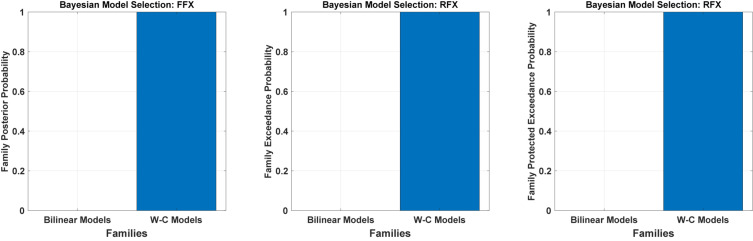
Results of Bayesian model comparisons for all possible models in the Family-level with standard bilinear equations and Wilson-Cowan (W-C) equations. This comparison is done with both FFX and RFX BMS.